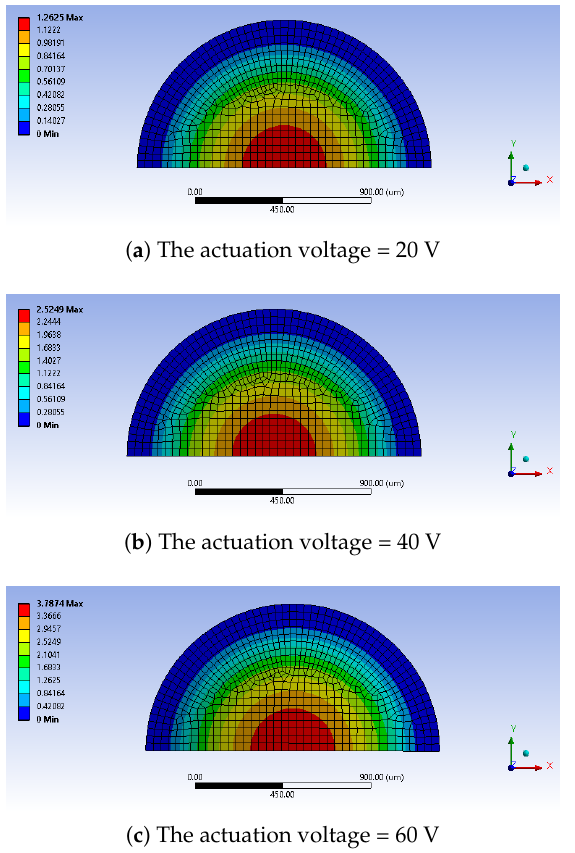
Figure 6. The deformation of the pumping diaphragm: contour plots of the transverse displacement in µ m.